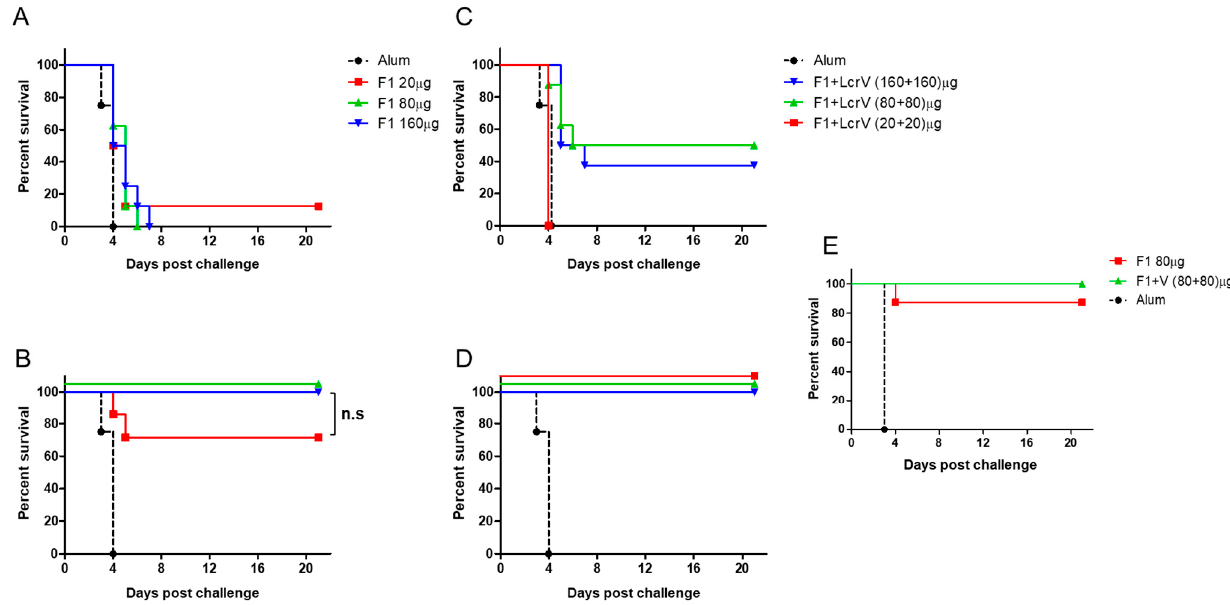
Figure 1. F1 and LcrV ability to induce rapid onset of immunity in a mouse model of pneumonic plague. Survival curves of C57BL/6 mice ( n = 8) vaccinated with the indicated dose of AlOH-adsorbed polyF1 or with a mixture polyF1 and LcrV three days ( A , C ) or seven days ( B , D ), respectively, before an intranasal challenge with Y. pestis Kim53 (10 LD50). ( E ) Survival curves of C57BL/6 mice ( n = 8) vaccinated either with polyF1 or with polyF1 and LcrV seven days prior to a tenfold intranasal challenge (100 LD50). Mortality of control, AlOH-vaccinated animals ( n = 4), is marked by a dashed black line. n.s. = nonsignificant differences according to the log-rank test.